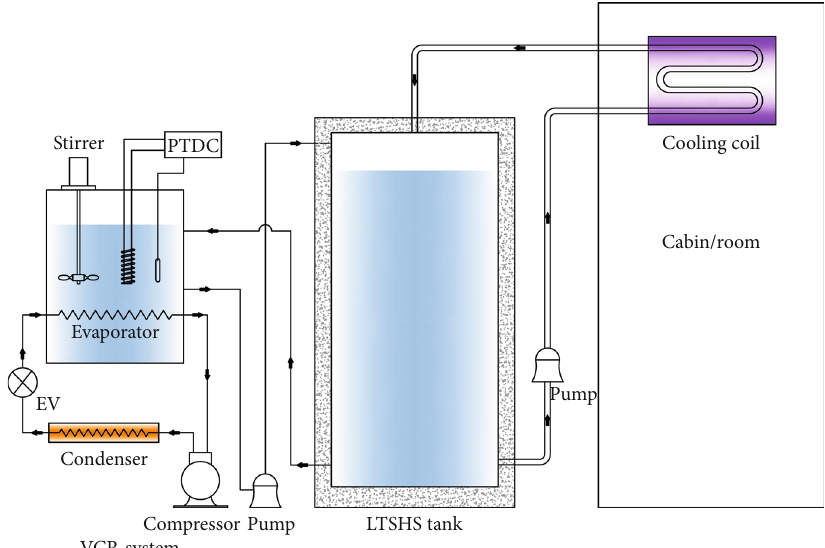
Figure 1: Schematic view of the experimental setup.